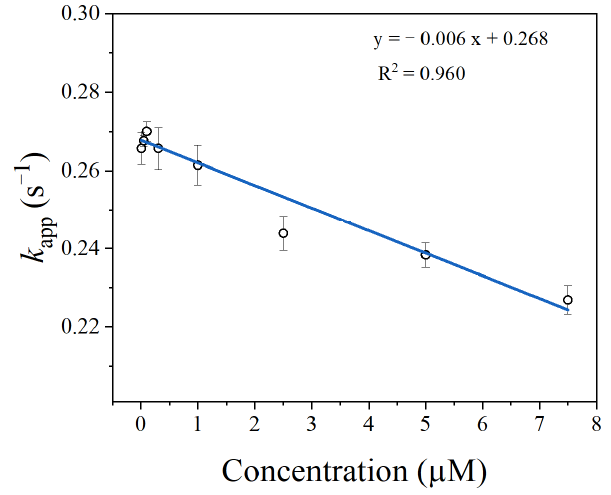
Figure 11. Detection of thrombin in 1% mouse serum sample using the developed SITS-Thrombin27 5 ′ aptasensor.